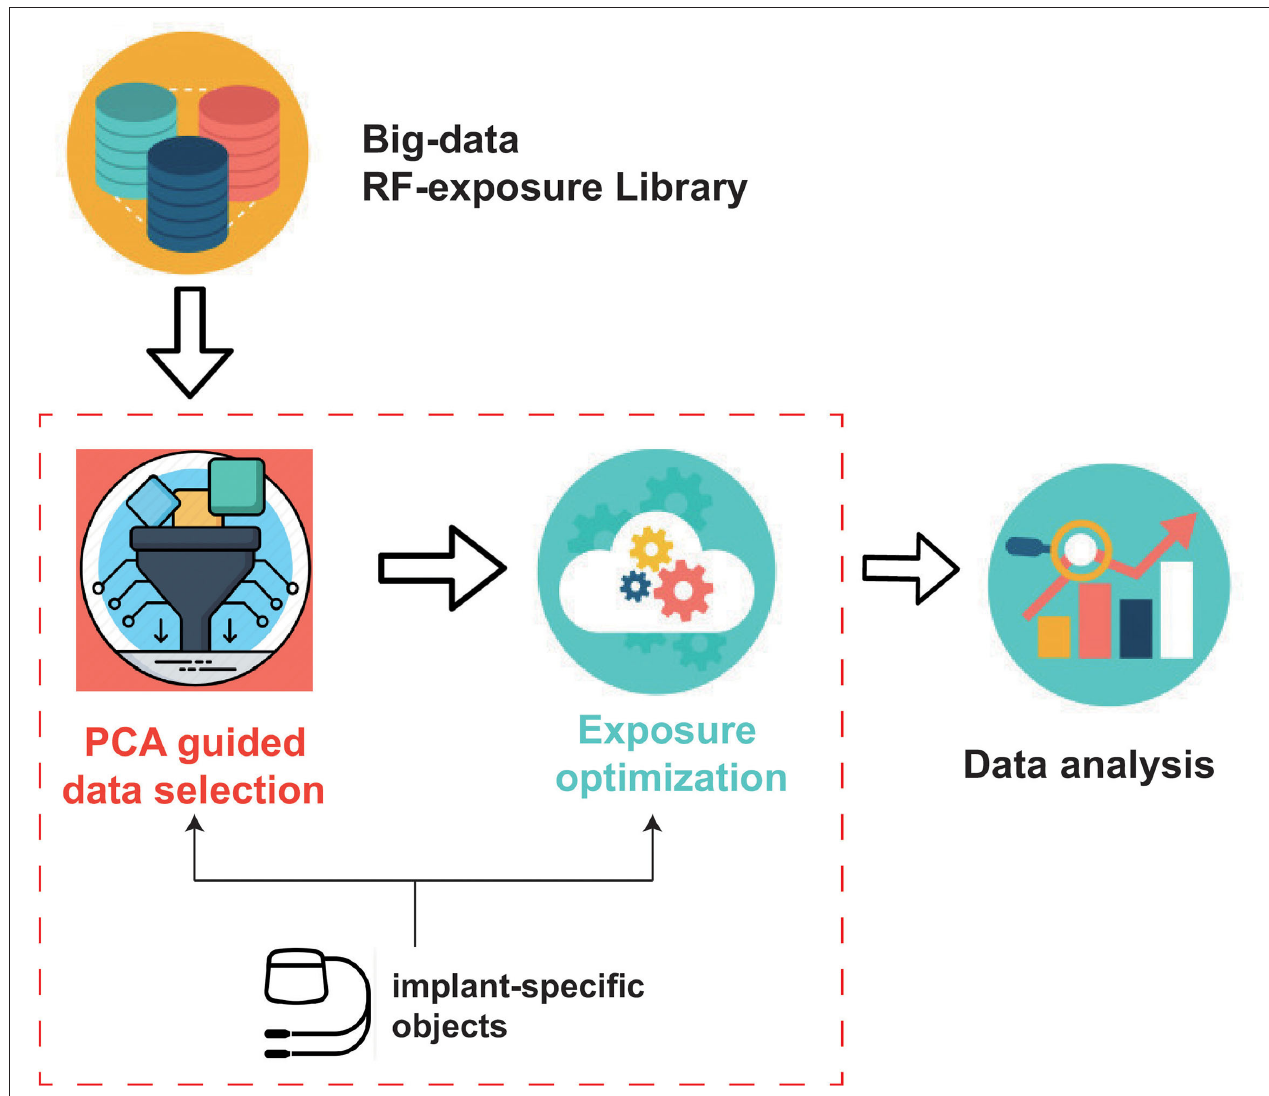
FIGURE 1 | Proposed exposure optimization